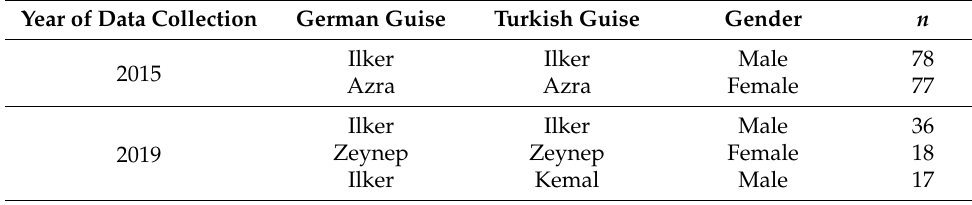
Table 2. Guises for the 2015 and 2019